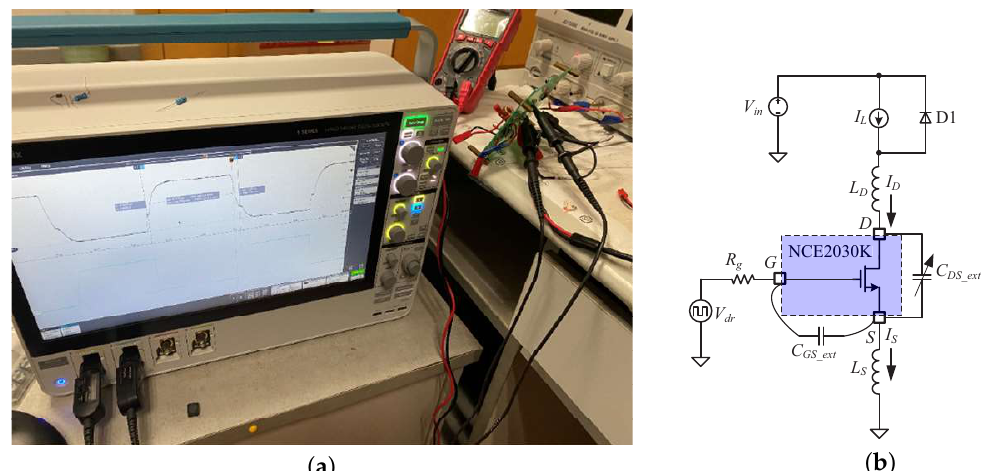
Figure 3. ( a ) Experimental validation of the newly calculated Miller plateau by testing NCE2030K; ( b ) testing setup of NCE2030K.